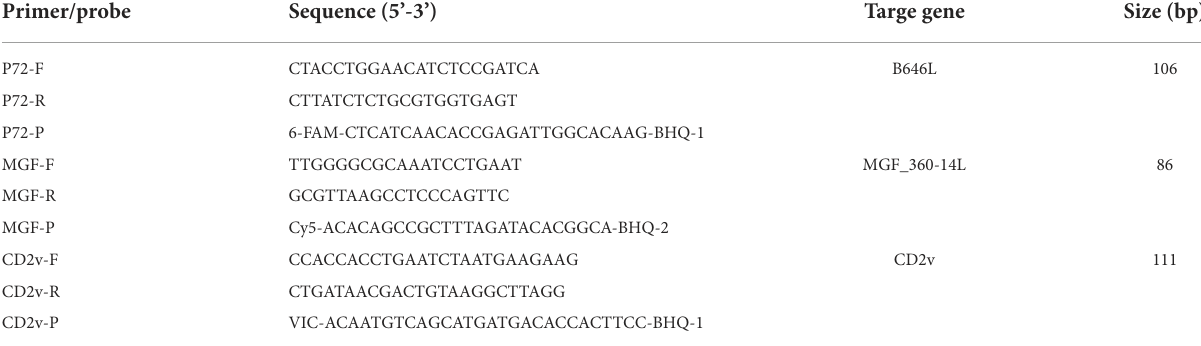
TABLE 1 Primers and probe sequences used in this